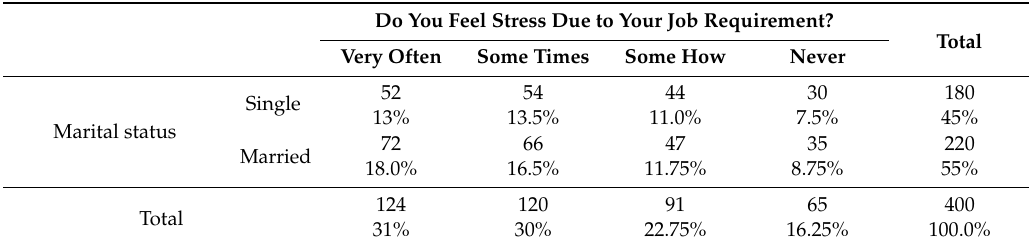
Table 19. Tabulation for marital status and stress level of